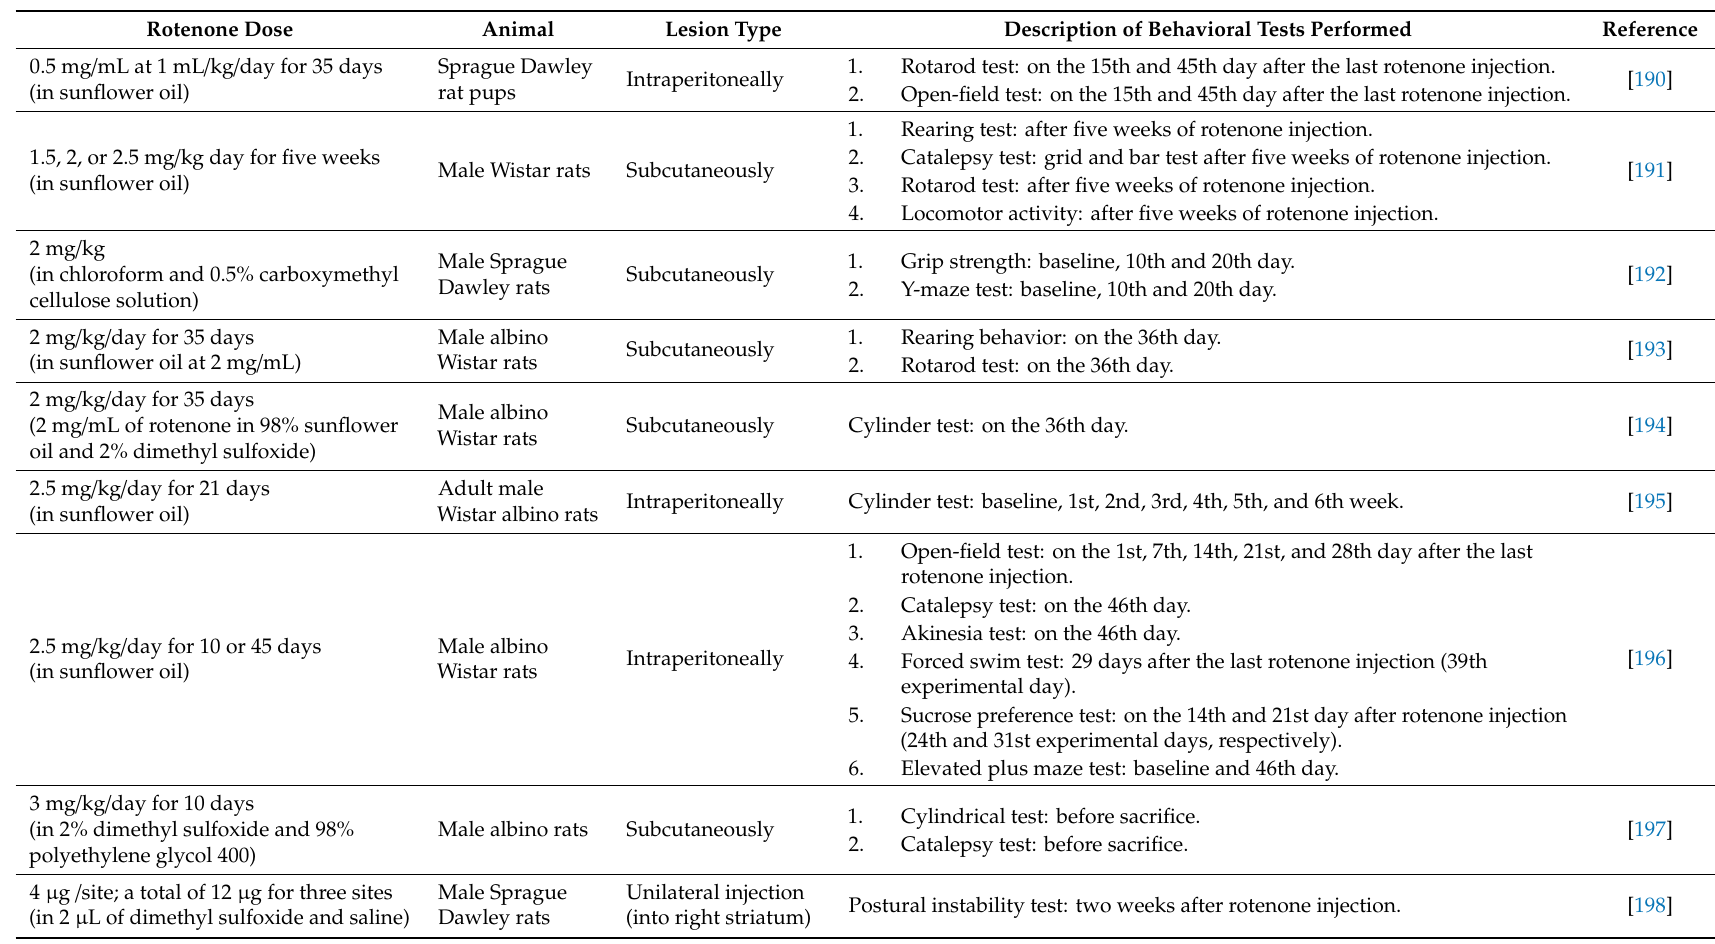
Table 6. The dose, lesion type, and behavioral evaluating methods in each rotenone-induced PD animal model. Animal Lesion